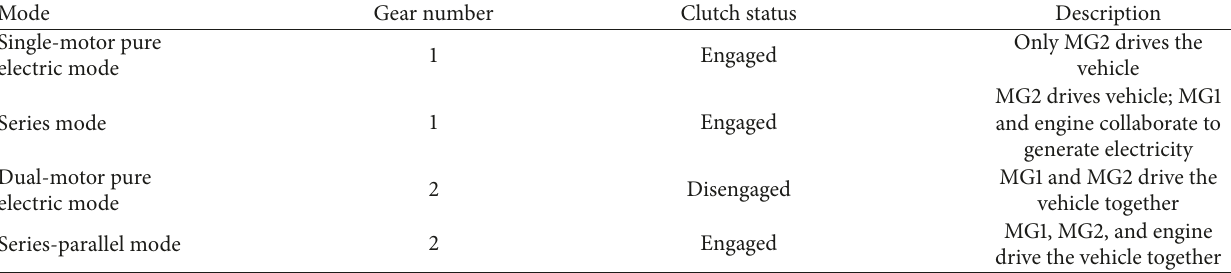
Table 1: The four operation modes of new HEV system.